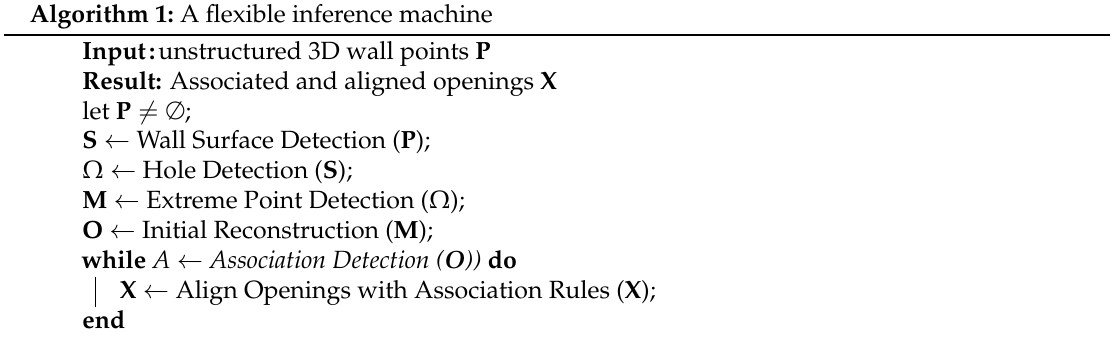
Algorithm 1: A flexible inference